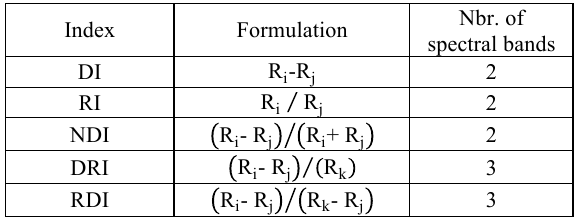
Table 1. Formulations of vegetation indices